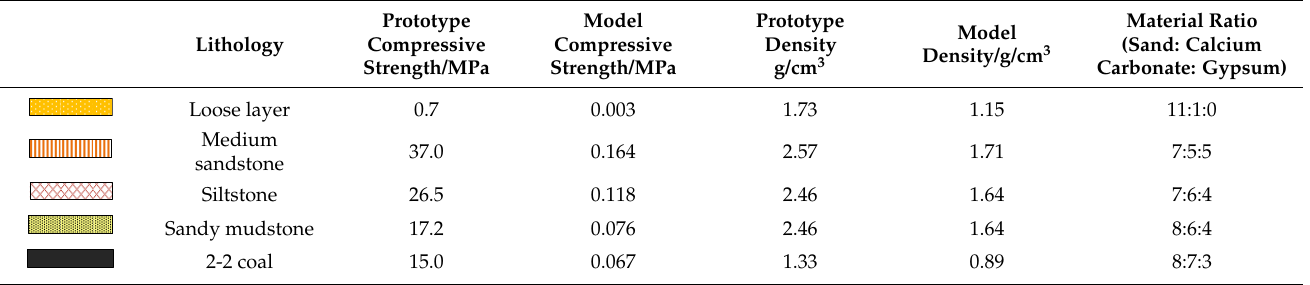
Table 1. Physical and mechanical parameters and compounding ratio of the prototype and modeling materials.